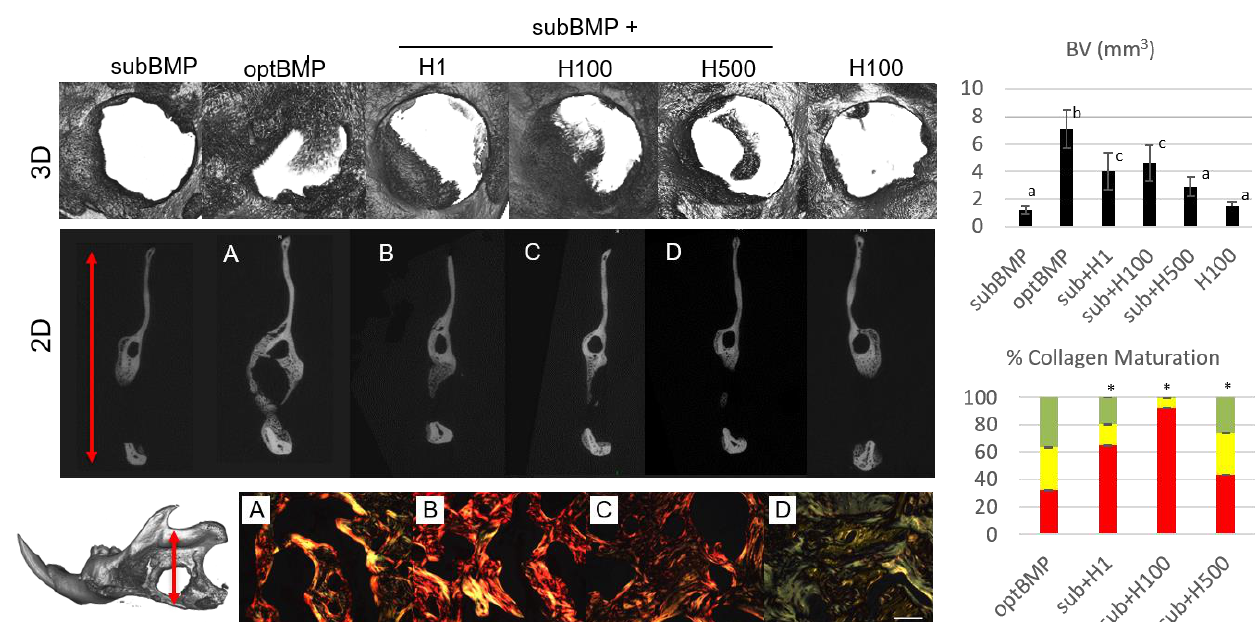
Figure 5. In vivo study of bone regeneration modulation by local delivery of bone morphogenetic protein 2 (BMP2) and hesperidin (H) in a rat mandible critical-sized defect ( n = 4/group). Microcomputed tomography ( µ CT) 3D images (top row) show increased bone formation with use of a large dose of BMP2 (optimal dose of 1 µ g of BMP2, optBMP) compared to a small dose (suboptimal dose of 100 ng of BMP2, subBMP). Different superscript letters on the top-right chart (BV, bone volume) indicate statistical difference among groups ( p < 0.05). When subBMP was delivered with three different doses of H, a significantly greater amount of newly formed bone (NFB) was found for subBMP+ H1 (1 µ M) and H100 (100 µ M) compared to subBMP alone (3D and 2D µ CT panels and BV graph). The 2D µ CT view is a coronal cross-section of the 5-mm mandible defect (rat mandible depicted on bottom left with red arrow indicating where the 2D cross-section was taken). The 2D view provides additional understanding of the bone fill within the defect as compared to the 3D view, which is a median plane perspective that does not show the ectopic nature of optBMP. The NFB for H-treated samples was found to be within the constraints of the defect ( µ CT 2D panels B – D ) as opposed to optBMP ( A ). BV for H100 alone was not statistically different from control subBMP (top-right bar graph). Bottom-right chart shows the effect of H on collagen organization of the NFB during BMP-induced bone formation. Polarized light images (20 × , bar 200 µ m) of PSR-stained NFB (bottom row) highlight differences in the organization/maturation of the bone matrix as there was an increase in more mature collagen (red fibrils) in H-treated samples with lower doses of H (B and C) (* in bar graph indicates statistical difference in red fibril percentage compared to optBMP, p < 0.05). SubBMP and H100 PSR alone were not quantified due to the limited amount of NFB. ( n = 4 images/animal).